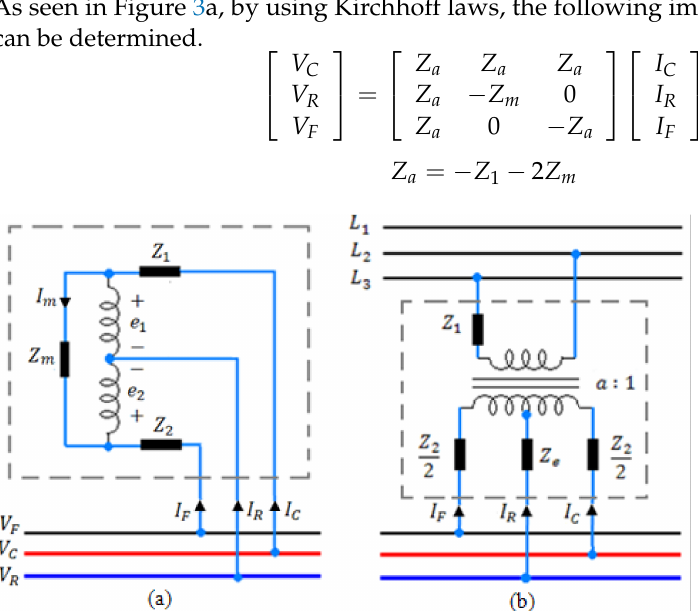
Figure 3. ( a ) The impedance model of AT and ( b ) the impedance model of